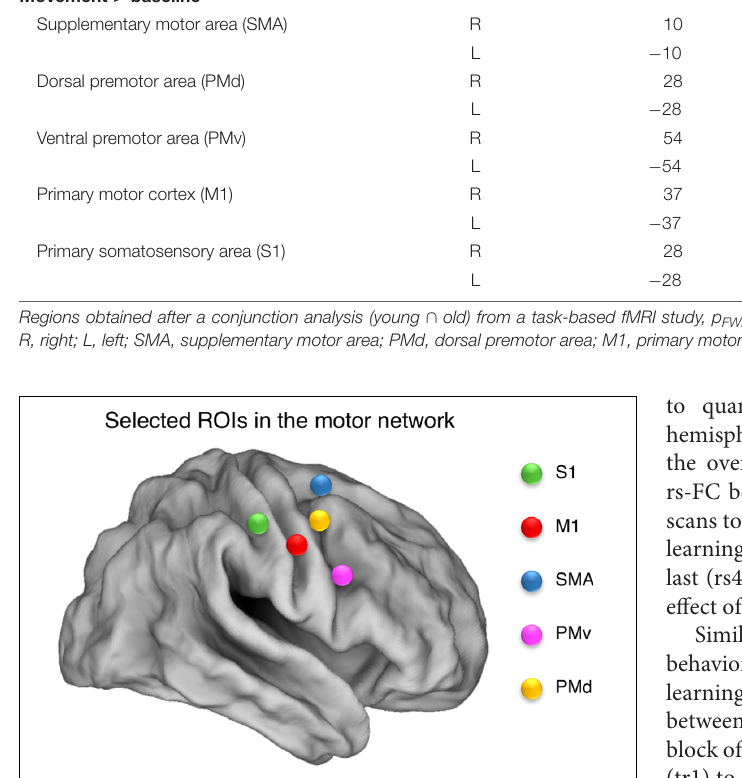
FIGURE 2 | Selected ROIs in the motor network. Spherical ROIs were defined bilaterally for the following areas: SMA, supplementary motor area; PMd, dorsal premotor area; M1, primary motor cortex; S1, primary somatosensory area; PMv, ventral premotor area. The ROIs are illustrated over a cortical representation for the right hemisphere